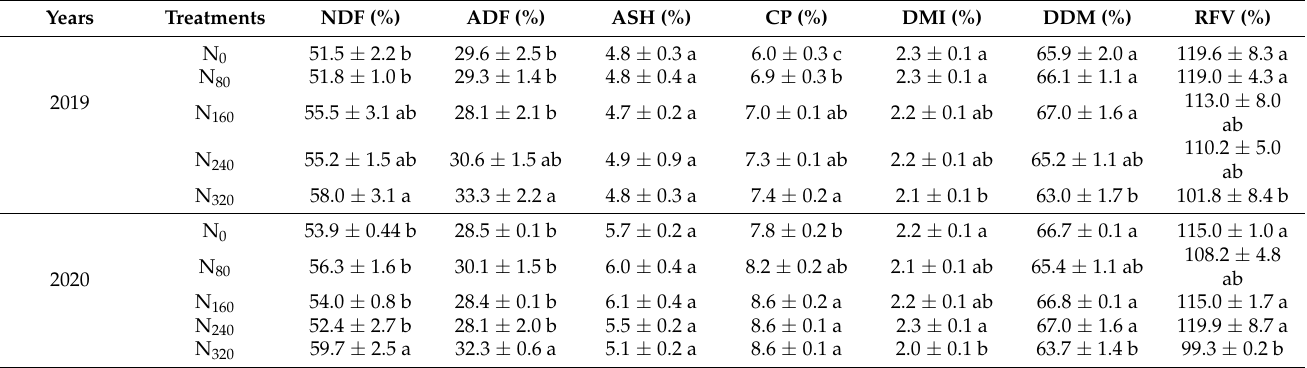
Table 2. The NDF, ADF, ASH, CP, DMI, DDM, and RFV of forage sorghum at the harvest stage under different N application rates in 2019 and